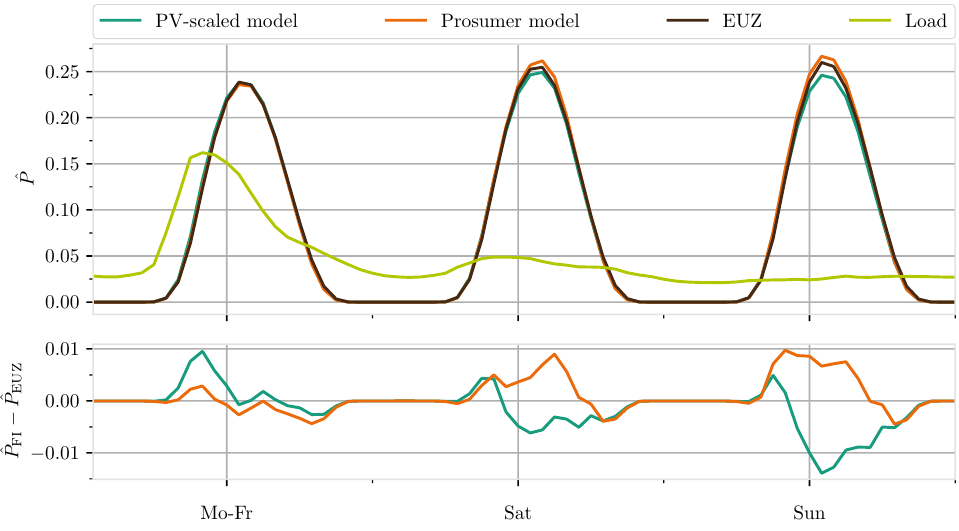
Figure 4. ( Top ) Type week of specific feed-in in the “PV-scaled” reference model and the prosumer model in comparison with the transfer time series EUZ and the specific load. ( Bottom ) Specific feed-in difference between the two models and the EUZ in the type weeks